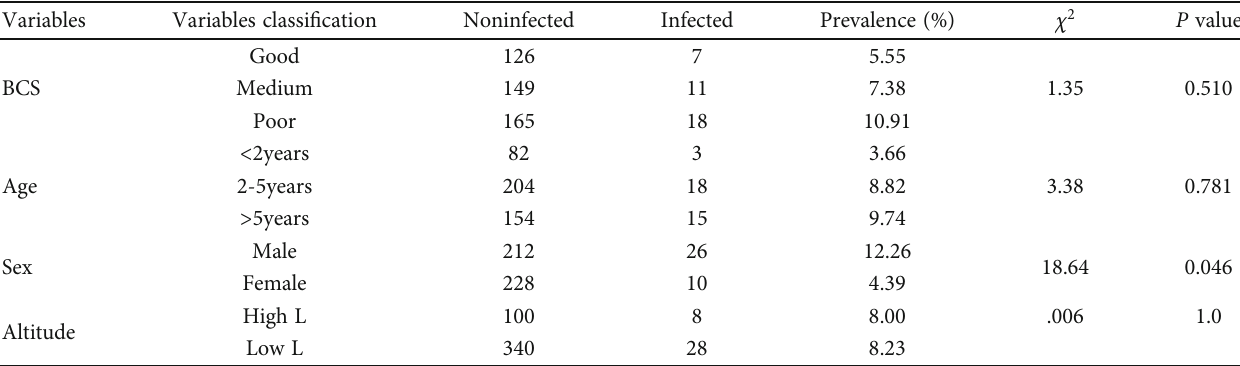
Table 2: Association between prevalence and risk factors.